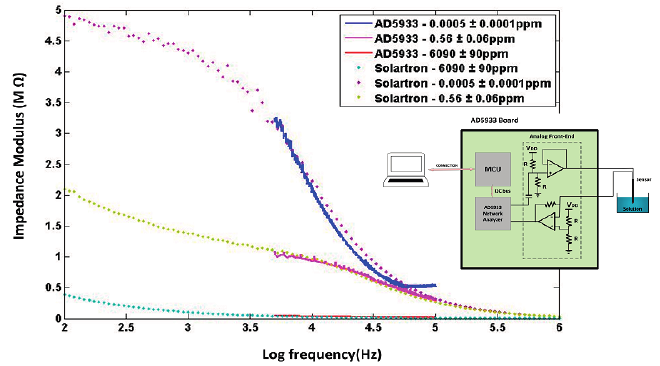
Figure 5. Comparative sensor impedance measurements made between the AD5933 microelectronics platform and the Solartron Impedance